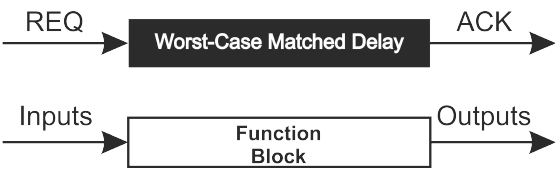
Figure 5. Worst-Case Bundled-data completion detection